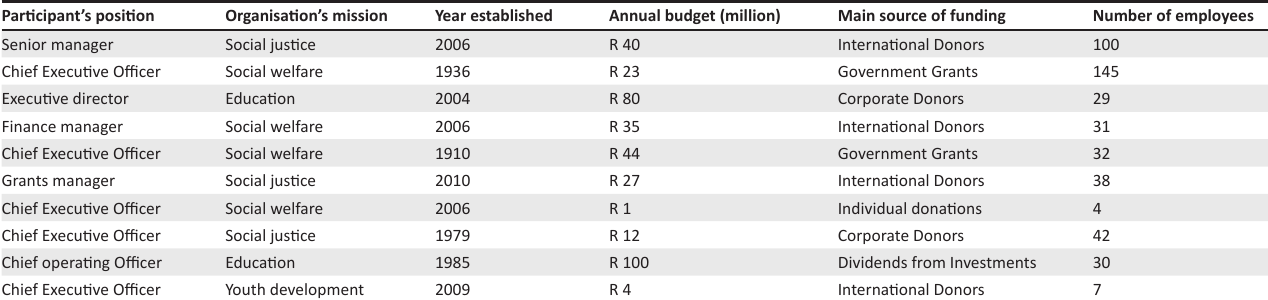
TABLE 1: Profile of participants.